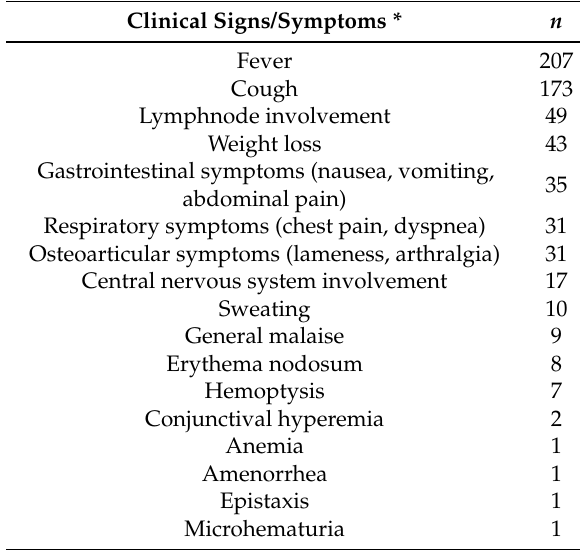
Table 2. Clinical signs/symptoms of the active tuberculosis